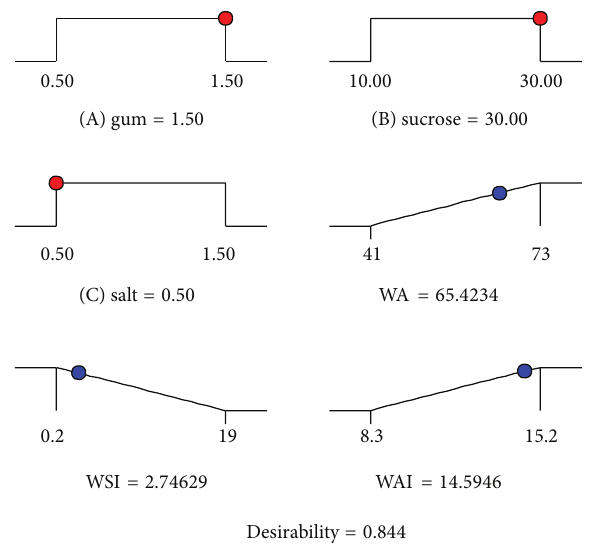
Figure 2: Graphical representation of optimized levels of indepen- dent variables of lotus stem